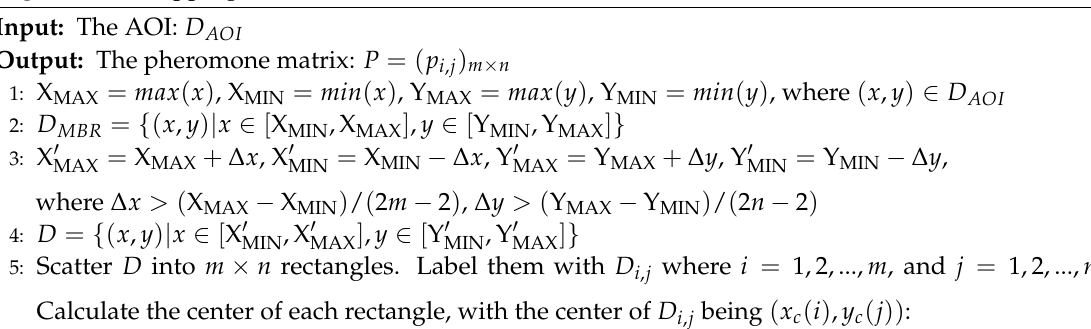
Algorithm 1 Mapping D AOI into